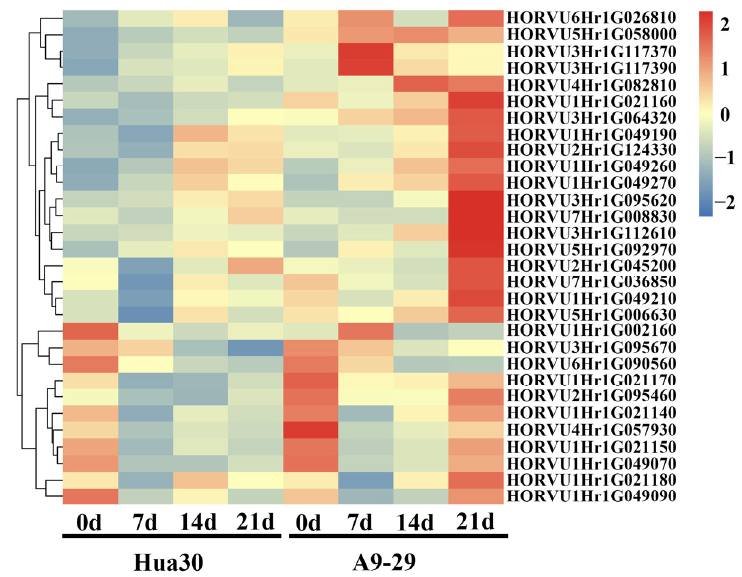
Figure 6. The average linkage hierarchical cluster analysis of DEGs encoding GSTs.